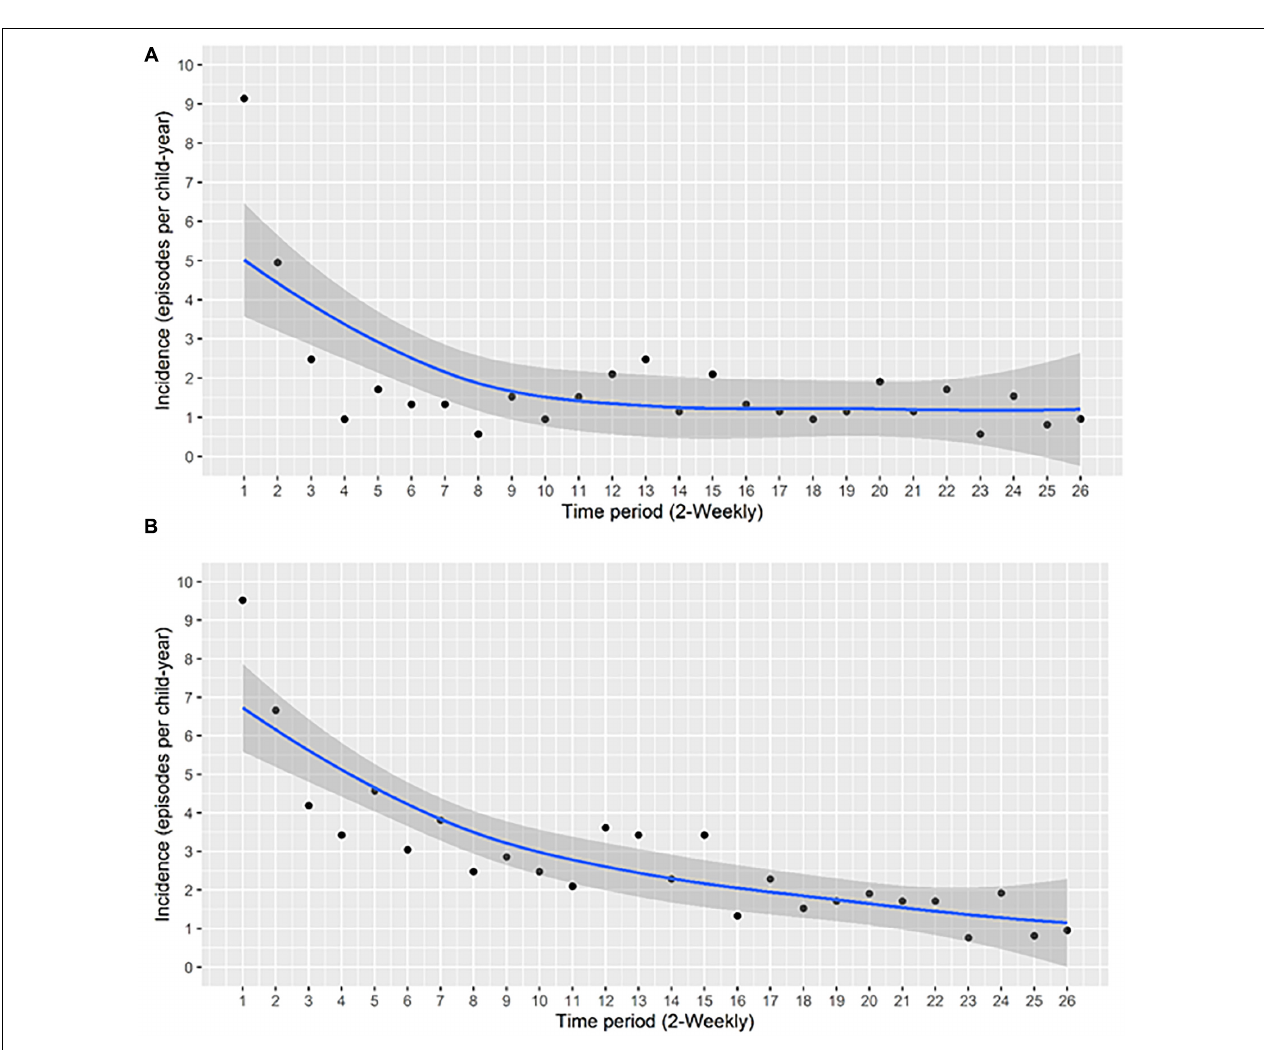
FIGURE 1 | The incidence of acquisition of S. aureus NP carriage during the first year of life at the (A) species level and (B) at the genotype level. The incidence of acquisition per child-year at 2-weekly intervals was calculated. Each data point represents the incidence of acquisition over the period between the previous and the indicated time point. A smoothing function shown by the blue line, with a 95% confidence interval for the smoothing function (the area shaded in gray), was fitted.